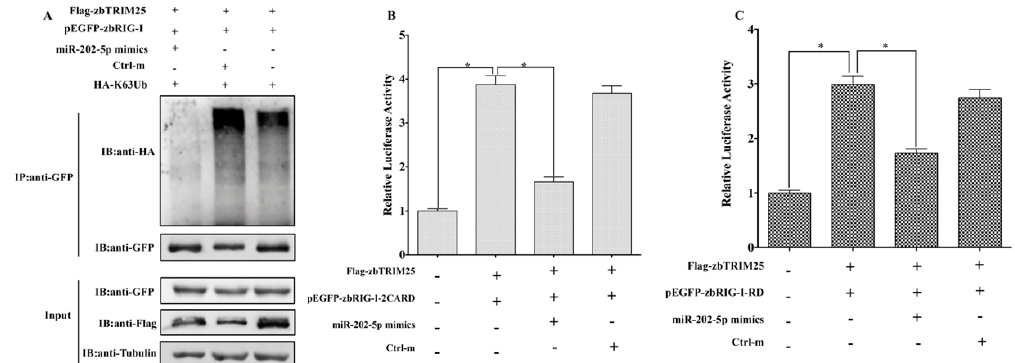
Figure 7. miR-202-5p inhibits zbTRIM25-mediated zbRIG-I ubiquitination and interferon (IFN) promoter activity. ( A ) HEK 293T cells were transfected with plasmids and miR-202-5p mimics or Ctrl-m as indicated for 24 h. At 24 h after poly I:C treatment, cells were lysed, and the cell lysates were either analyzed directly by using anti-GFP, anti-Flag, and anti-Tubulin antibodies via Western blotting (input) or subjected to immunoprecipitation using anti-GFP antibodies. The precipitates (IP) were analyzed by Western blotting with anti-GFP and anti-HA antibodies, respectively. HEK 293T cells were transfected with pCMV-Flag or pCMV-Flag-zbTRIM25 , miR-202-5p mimics or Ctrl-m together with pEGFP-zbRIG-I-2CARD ( B ) or pEGFP-zbRIG-I-RD ( C ) as well as pGL3-DrIFN 1-pro-Luc and pRL-TK plasmids. Luciferase activities were measured and normalized to the amount of Renilla luciferase activities. Data represent the mean ± SD ( n = 3). Asterisks indicate the significant differences between groups (*: p < 0.05 ).